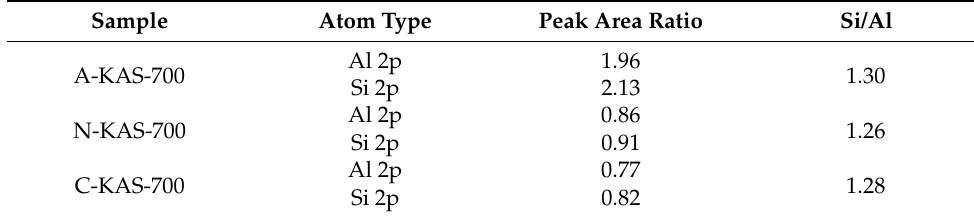
Figure 11. Al 2p and Si 2p photoelectron spectra of KAS calcined at 700 °C under different atmospheres. Table 5. The changes in peak areas and the atomic ratios of Si to Al of the samples.